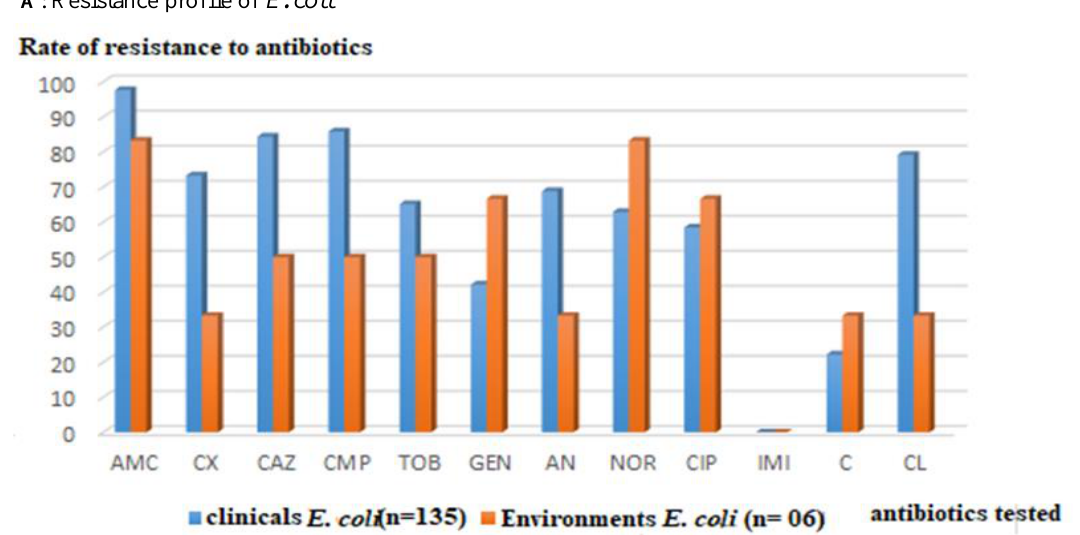
Figure 3 (A; B; C and D). Resistance profile of isolates clinicals and environments. A : Resistance profile of E. coli